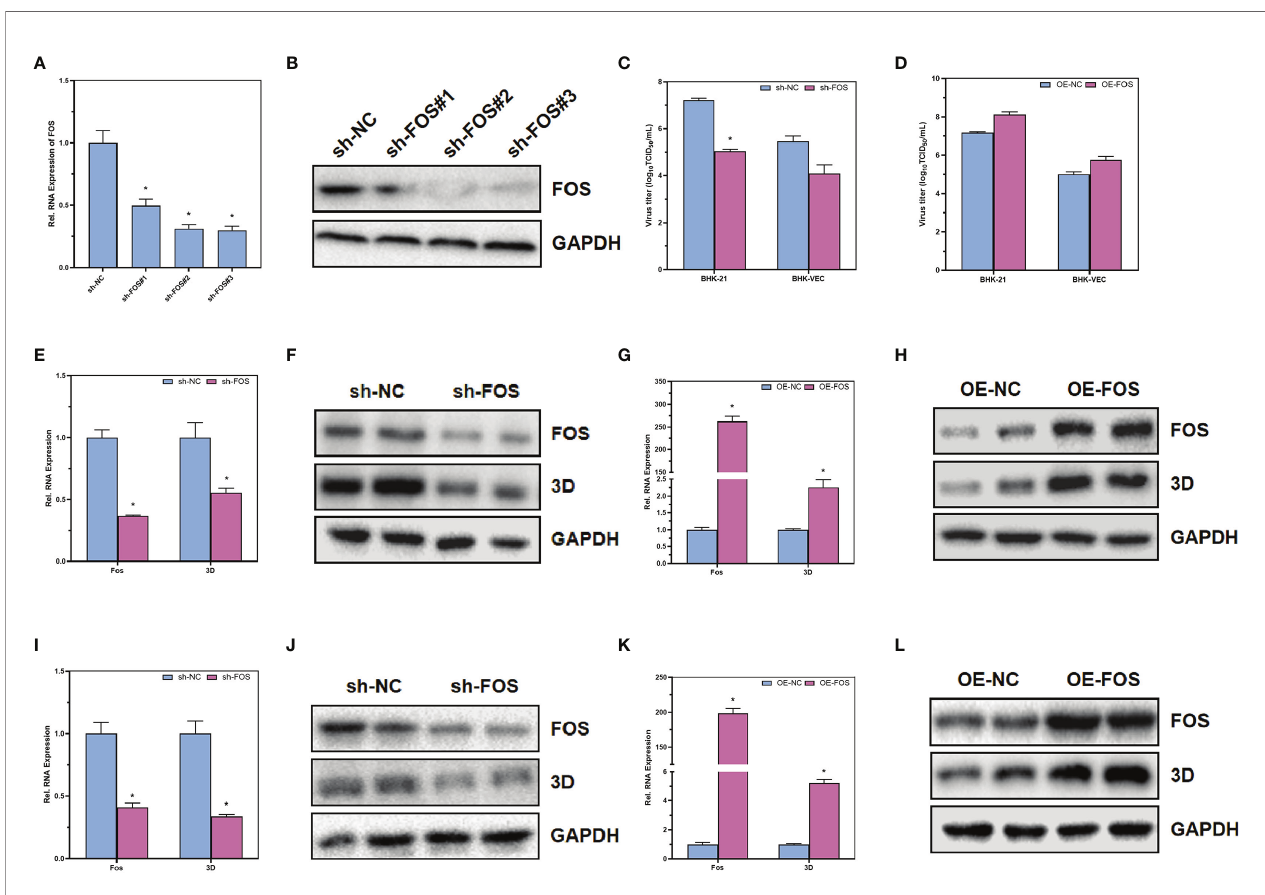
FIGURE 6 | The effects of transcription factor FOS on acute and persistent FMDV infection. The RNA and protein expression levels of FOS in BHK-21 after transfected with shRNA were veri fi ed by RT-qPCR (A) and Western blot (B) . The infectious FMDV titers in BHK-21 cells (C) and BHK-VEC cells (D) were veri fi ed by TCID 50 assay. The RNA and protein expression levels of FOS and FMDV 3D in BHK-21 after downregulation of FOS in BHK-21 cells were veri fi ed by RT-qPCR (E) and Western blot (F) . The RNA and protein expression levels of FOS and FMDV 3D in BHK-21 after upregulation of FOS in BHK-21 cells were veri fi ed by RT-qPCR (G) and Western blot (H) . The RNA and protein expression levels of FOS and FMDV 3D in BHK-VEC after downregulation of FOS in BHK-VEC cells were veri fi ed by RT-qPCR (I) and Western blot (J) . The RNA and protein expression levels of FOS and FMDV 3D in BHK-VEC after upregulation of FOS in BHK-VEC cells were veri fi ed by RT-qPCR (K) and Western blot (L) . Sh, shRNA; OE, over expression; NC, negative control. GAPDH was served as the internal reference to normalize data. Three independent replicates were conducted for each sample. Data are expressed as the means ± SE (n = 3). * P < 0.01